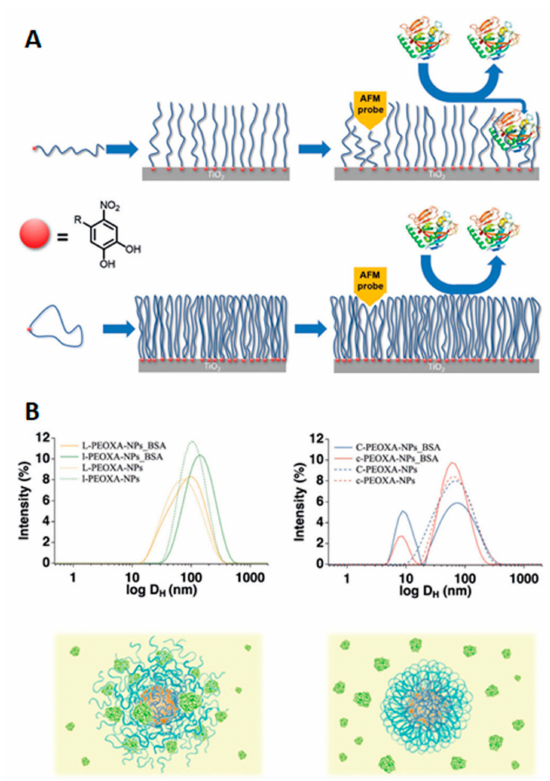
Figure 10. Antifouling cyclic poly-2-ethyl-2-oxazoline (PEOXA) and its e ff ect on protein adsorption. ( A ) surfaces coated with linear (top) or cyclic (bottom) polymers and representation of their interaction with proteins. Reprinted with permission from reference [53]. Copyright (2017) Wiley. ( B ) DLS traces and schematic representation showing the interaction of BSA with nanoparticles coated with linear ( left ) or cyclic ( right ) polymers. Reprinted with permission from reference [57]. Copyright (2017)